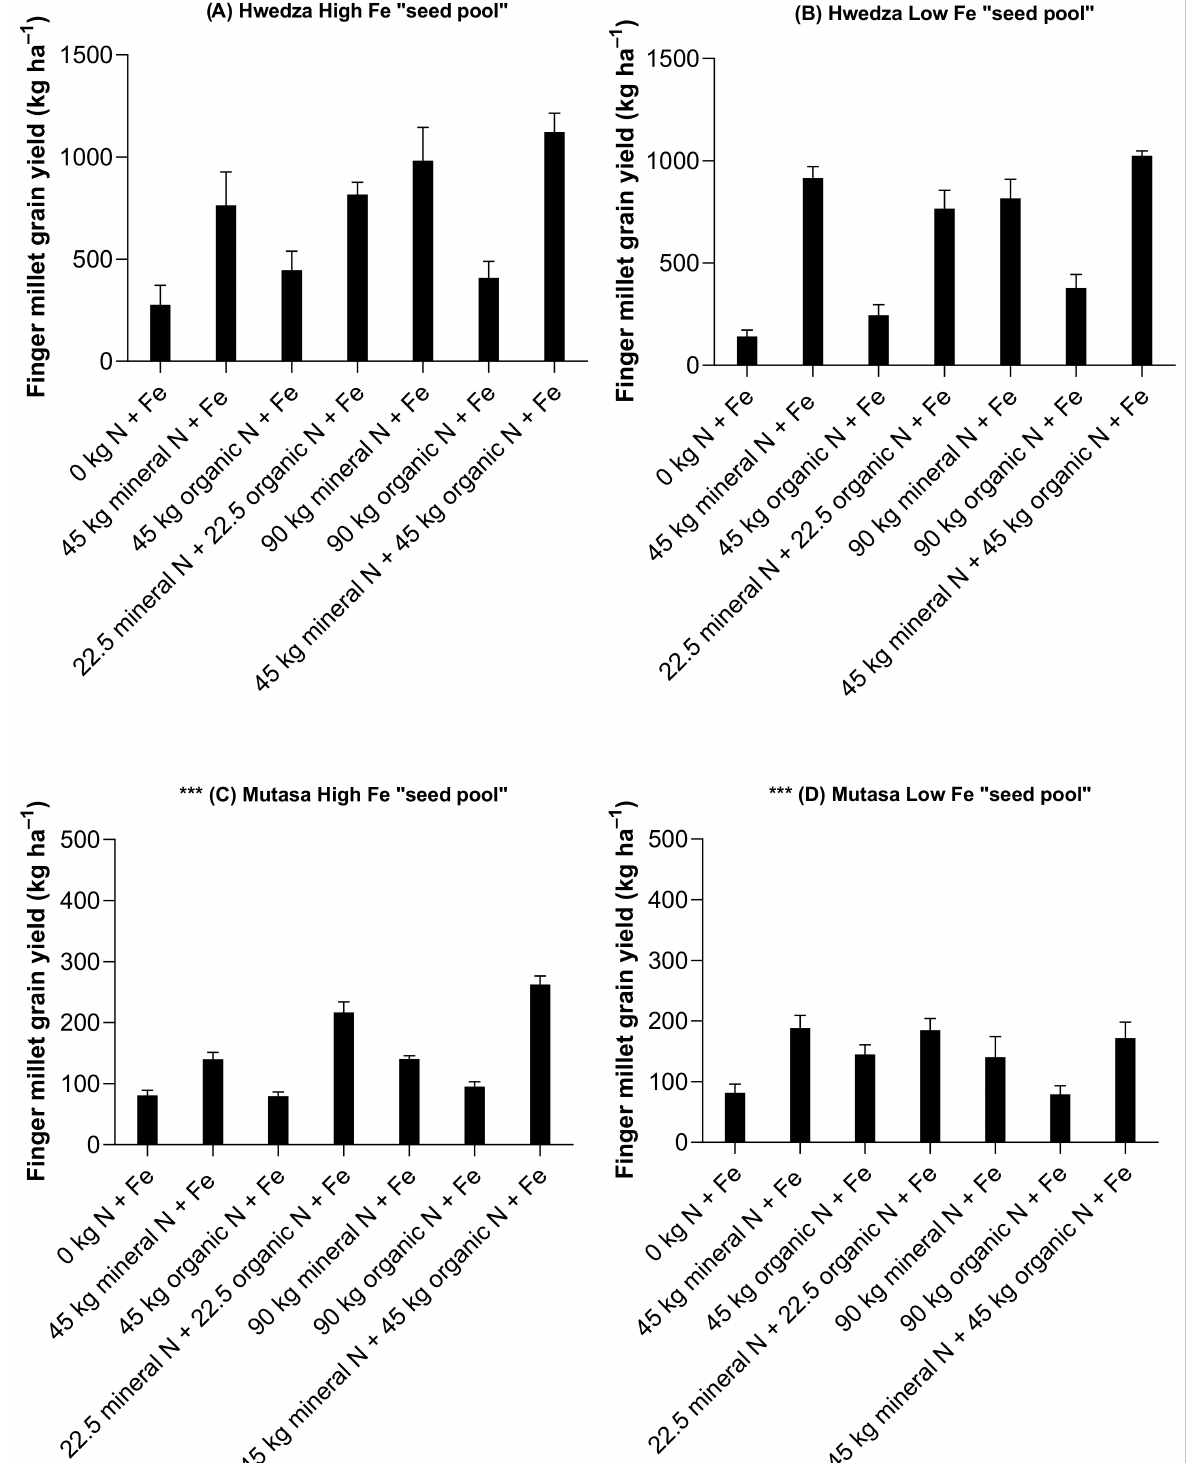
Figure 4. Mean grain yields ( ± standard error of means, SEM) of two finger millet “seed pools” in ( A ) Hwedza “High Fe seed pool”; ( B ) Hwedza “Low Fe seed pool”; ( C ) Mutasa “High Fe seed pool”; and ( D ) Mutasa “Low Fe seed pool”. ***, indicate that graphs 4C,D have different y-axes scales to graphs